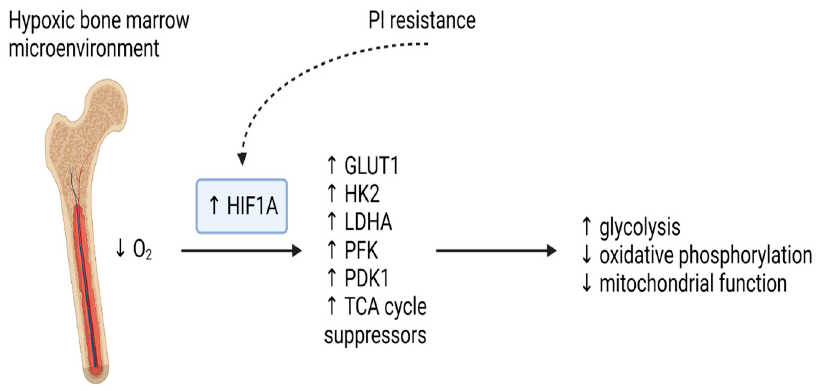
Figure 2. HIF1A expression is increased by both hypoxic conditions and the development of PI resistance, leading to upregulation of glucose transporters and glycolytic enzymes, which in turn promote a metabolic shift to increased glycolysis, along with suppression of oxidative phosphorylation and decreased mitochondrial function. GLUT1: glucose transporter 1; HIF1A: hypoxia-inducible factor 1 alpha; HK2: hexokinase 2; LDHA: lactate dehydrogenase A; PDK1: pyruvate dehydrogenase kinase-1; PFK: phosphofructokinase; PI: proteasome inhibitor; TCA: tricarboxylic acid. HIF1A is also known to contribute to drug resistance in MM cells, and knockdown of HIF1A can overcome resistance to therapies such as bortezomib. LDHA similarly modulates MM drug resistance in areas of hypoxia. Knockdown of LDHA similarly restored the sensitivity of bortezomib-resistant MMCLs [16,17]. Additional support for their importance can be seen with gain-of-function studies of both HIF1A and LDHA inducing resistance in bortezomib-sensitive MMCLs, indicating their potential as therapeutic targets